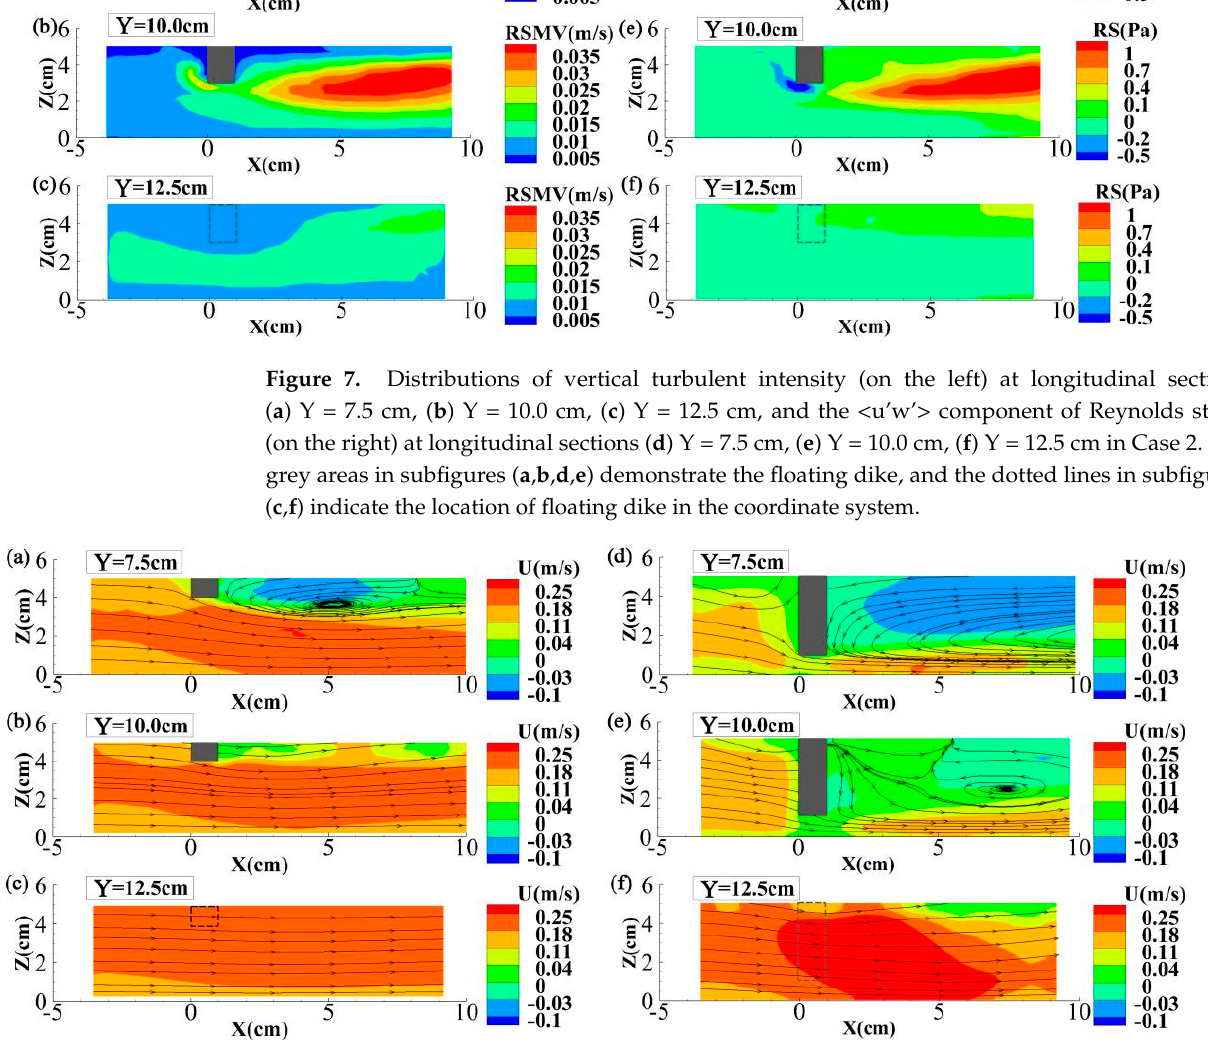
Figure 8. Distributions of velocity at longitudinal sections ( a ) Y = 7.5 cm, ( b ) Y = 10.0 cm, ( c ) Y = 12.5 cm in Case 3 (on the left) and at longitudinal sections ( d ) Y = 7.5 cm, ( e ) Y = 10.0 cm, ( f ) Y = 12.5 cm in Case 4 (on the right).The grey areas in subfigures ( a ), ( b ), ( d ) and ( e ) demonstrate the floating dike, and the dotted lines in subfigures ( c ) and ( f ) indicate the location of floating dike in the coordinate system. Table 3. Maximum or minimum (in the reverse direction) values for experimental parameters.